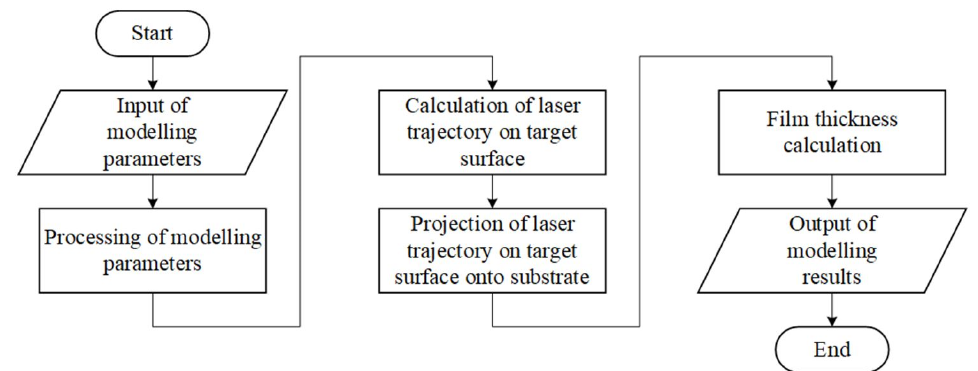
Figure 2. The main stages of films thickness calculation.